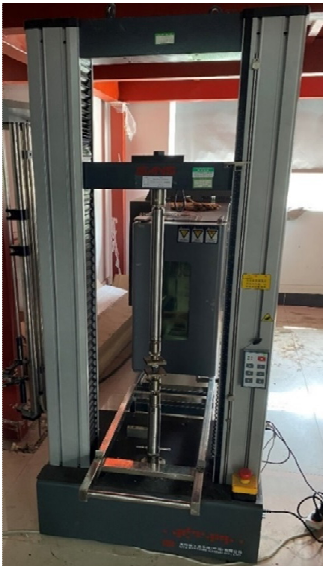
Figure 6. Universal testing machine.